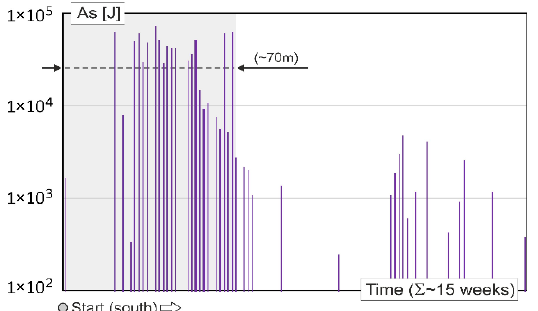
Figure 11. Histogram of seismic energy release — top heading Y#4.